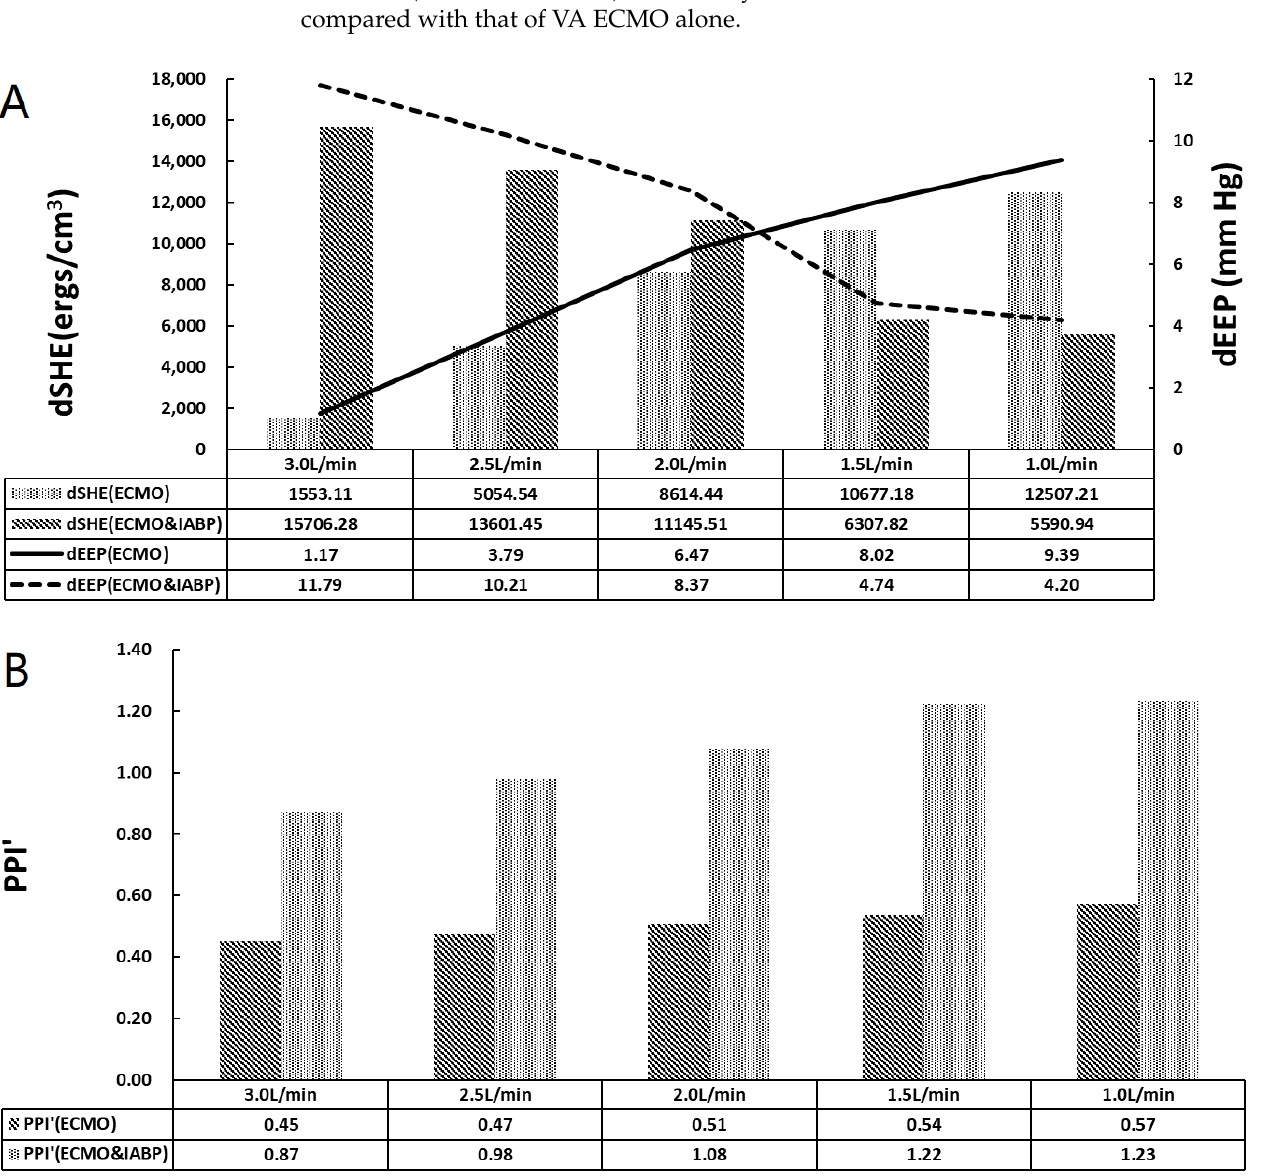
Figure 5. The pulsatile properties of arterial. ( A ) The histogram of dSHE and the curve of dEEP, dEEP is the difference value between LV EEP and V-A ECMO EEP; ( B ) The histogram of PPI’.